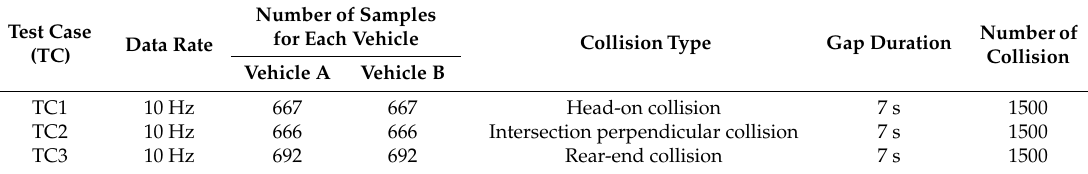
Table 3. Simulation test